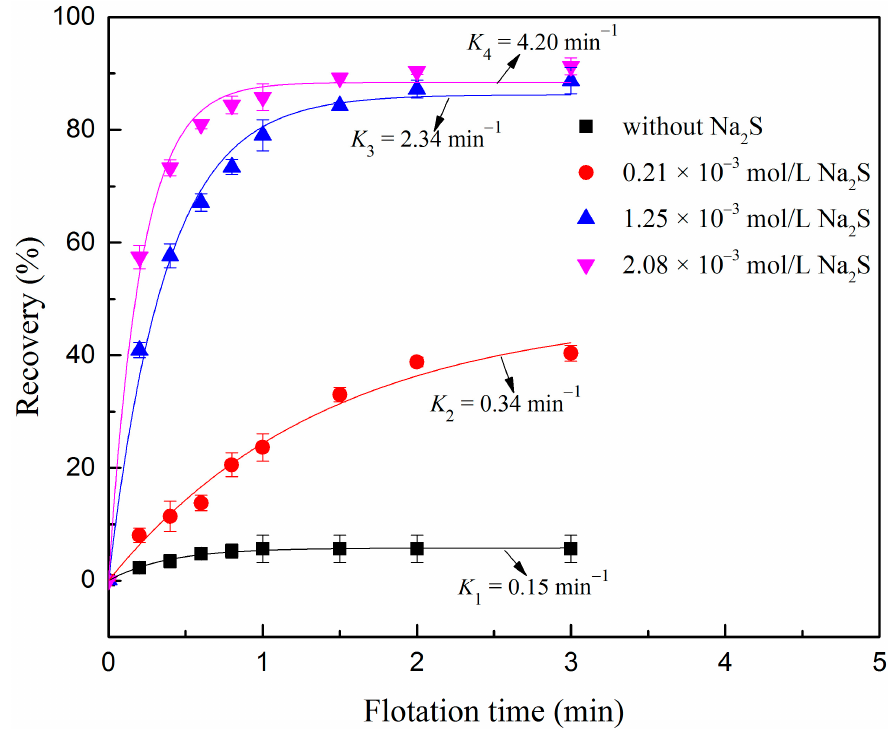
Figure 2. Flotation recovery of digenite as a function of flotation time with respect to Na 2 S dosage (pH: 7.0; sodium butyl xanthate (SBX) dosage: 1 × 10 − 4 mol/L). (pH: 7.0; sodium butyl xanthate (SBX) dosage: 1 × 10 − 4